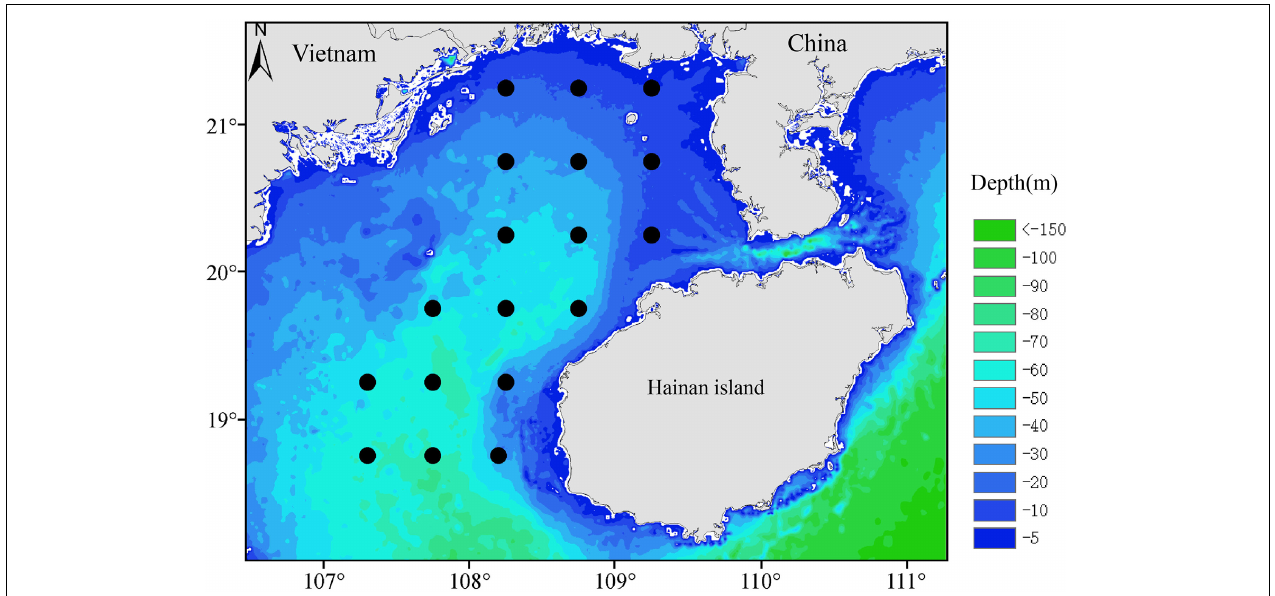
FIGURE 1 | Location of the 18 stations (bold dots) with the bottom trawl in the South China Sea.